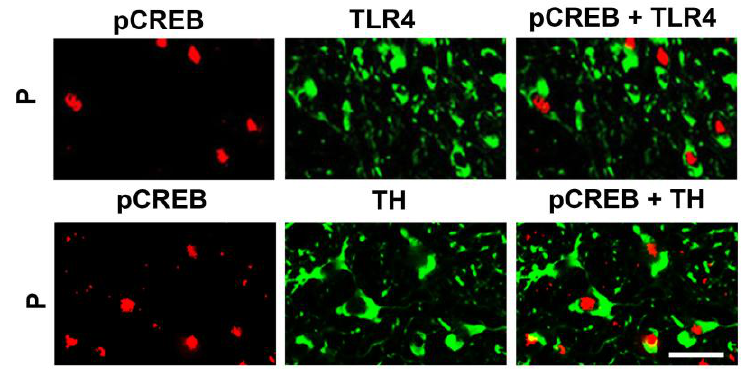
Figure 4. TH+ neurons in the VTA co-express TLR4 and nuclear pCREB. Confocal microscopy and Z-stack imaging of double immunofluorescent staining for pCREB + TLR4 or pCREB + TH is shown for the VTA of the P rats ( n = 5/group). Merged images for pCREB (red) and TH (green) reveal TH+ neurons that co-express intranuclear pCREB, and merged images for pCREB and TLR4 reveal TLR4+ neurons that co-express intranuclear pCREB. Scale bars are 20 μm.